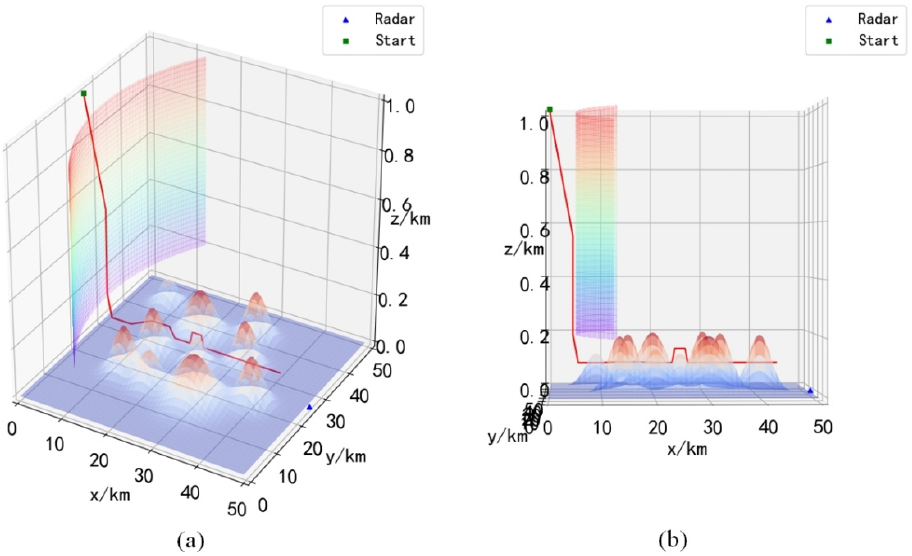
Figure 13. The path planning result in scenario 2. ( a ) is the full view of the path, ( b ) is the side view of the path.